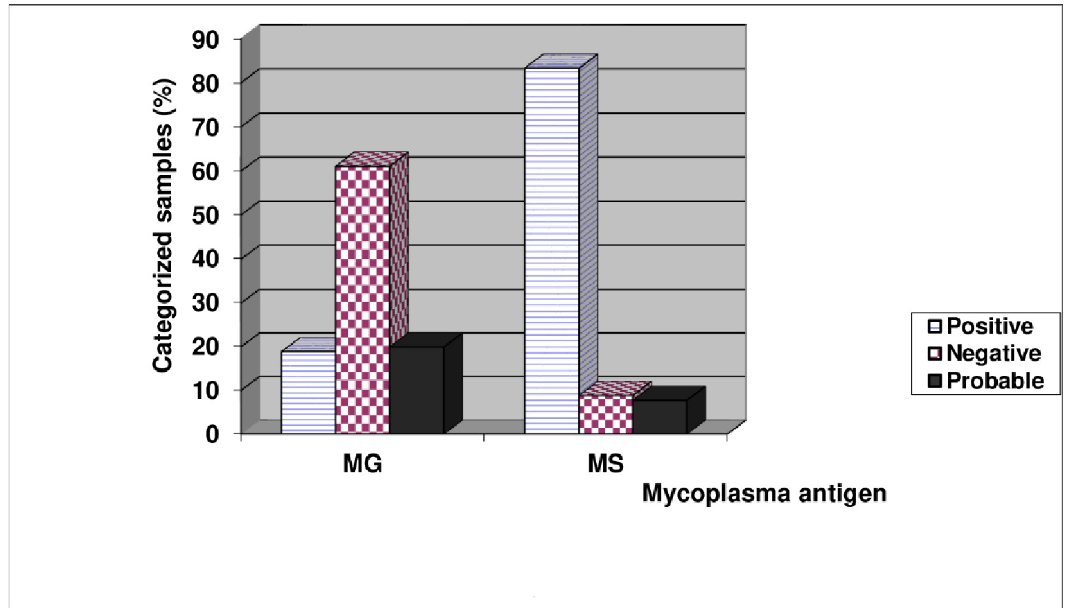
Fig 4. Incidence of Mg and Ms infection in different chicken breeds tested by